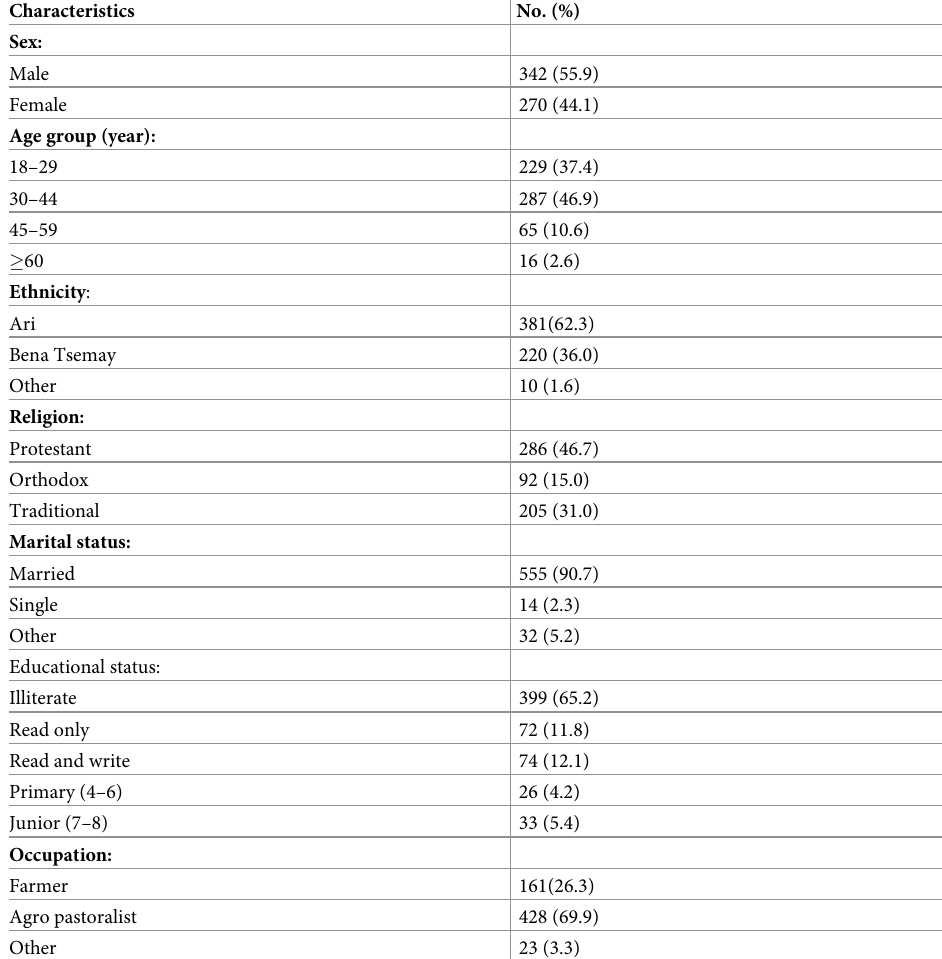
Table 1. Socio-demographic characteristics of the study participants.